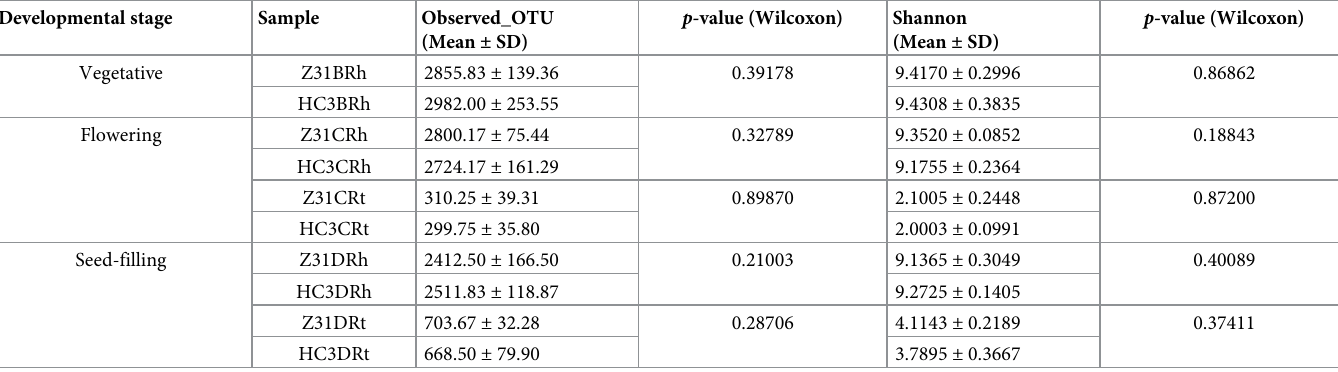
SD represents standard deviation. The significance test method was Wilcoxon rank-sum test (Wilcoxon). Values were mean ± SD (n = 4 or 6). Z31BRh, Z31CRh, and Z31DRh represent the rhizospheric bacterial communities of Z31 at the vegetative, flowering, and seed-filling stages, respectively. HC3BRh, HC3CRh, and HC3DRh represent the rhizospheric bacterial communities of HC3 at the vegetative, flowering, and seed-filling stages, respectively. Z31CRt and Z31DRt represent the root bacterial communities of Z31 at the flowering and seed-filling stages, respectively. HC3CRt and HC3DRt represent the root bacterial community of HC3 at the flowering and seed-filling stages,